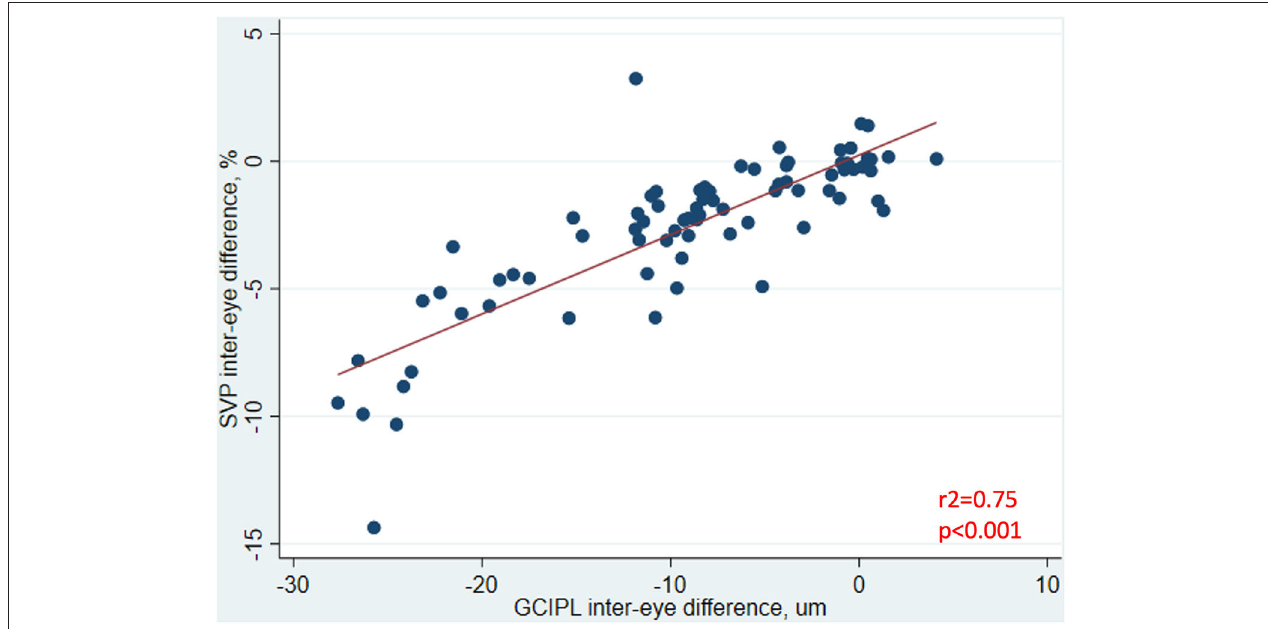
FIGURE 3 | Relationship between inter-eye differences in SVP density and GCIPL thickness in MS ON patients. In MS ON patients at least 3 months post-ON (after resolution of the acute phase of ON), the relationship between inter-eye differences in SVP density and GCIPL thickness is shown here. P -value was calculated using mixed-effects linear regression accounting for intra-subject correlations. R 2 -value was estimated from the mixed-effects model using the Snijders and Bosker method.